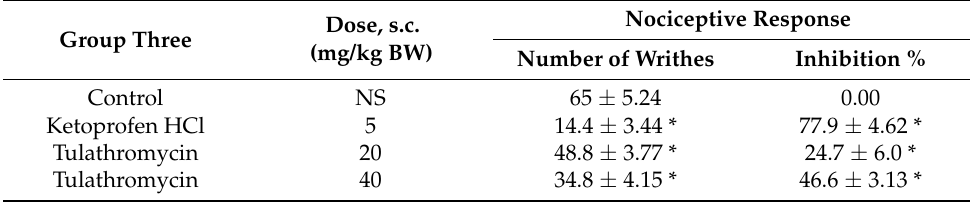
Table 3. Effects of tulathromycin (20 and 40 mg/kg BW, s.c.) and ketoprofen (5 mg/kg BW s.c.) on the acetic acid (10 mL/kg of 0.55% solution, i.p.)-induced writhing reflexes in mice (mean ± SD; n = 5).